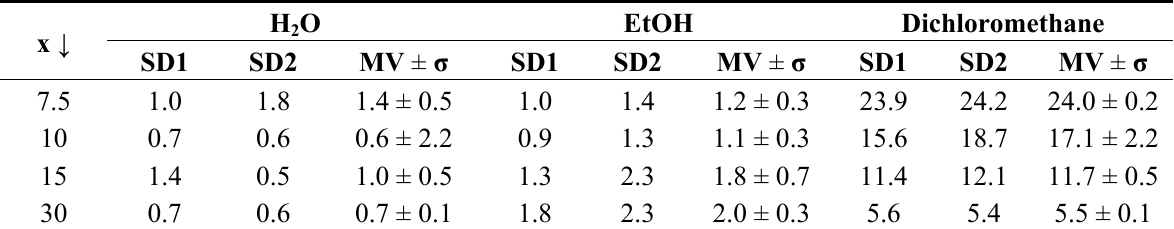
Table 5. The swelling degrees of p NonOx dichloromethane. The swelling degrees according to ( m in duplicate [SD1 and SD2, respectively; the average is represented by the arithmetic mean value (MV) and the standard deviation, σ